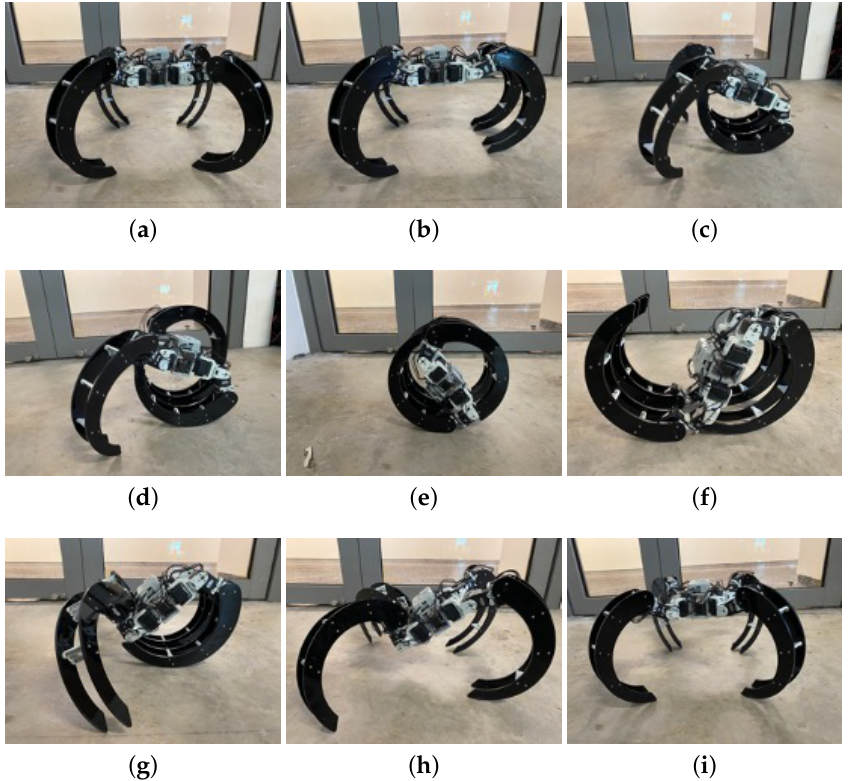
Figure 11. Transformation from crawling to rolling and back to crawling mode. ( a ) Crawling mode. ( b ) Frontal legs side by side. ( c ) Frontal legs under robot’s body. ( d ) Left back leg over robot’s body. ( e ) Rolling mode (frontal legs under robot’s body and back legs over it). ( f ) Back legs pushed out. ( g ) Back legs in crawling position. ( h ) Frontal legs pushed out and separated. ( i ) Crawling